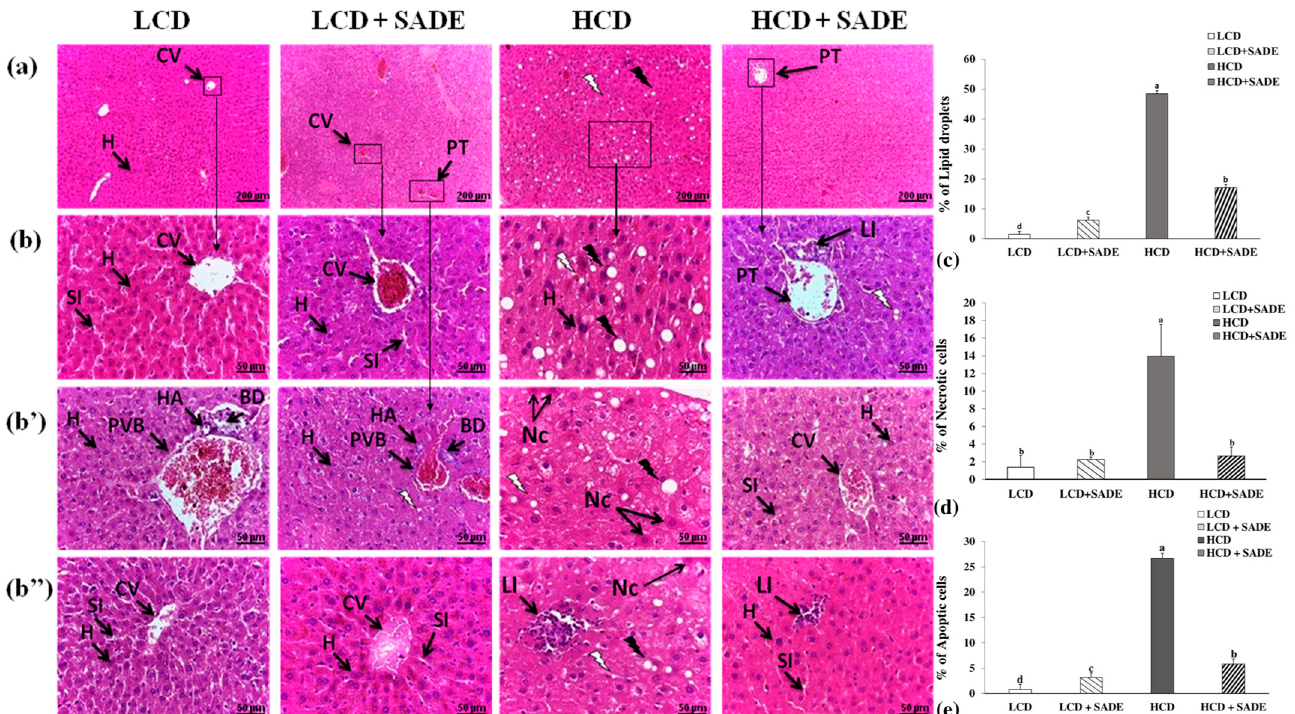
Figure 7. Histological analysis of liver tissues by hematoxylin-eosin (H&E) staining (( a ): magnifica- tion, 10 × , scale bar = 200 µ m), (( b – b” ): magnification, 40 × ; scale bar = 50 µ m). ( b – b” ) represent the different regions of the same slide of each group. Liver sections of LCD: animals group fed with natural low-calorie vegetable diet and LCD + SADE: LCD group treated with S. arabica decocted showed the normal structure of hepatocytes with normal sinusoids and central vein and a normal portal with normal bile ducts ( a – b’’ ). Liver sections of HCD: rats fed with a high-calorie diet demon- strated moderate alterations such as microvesicular and macrovesicular fatty degeneration of hepatocytes ( a – b’’ ), inflammatory ( b’’ ) and necrosis cells ( b’ , b’’ ) and liver sections of HCD + SADE: rats fed with high-calorie diet treated with S. arabica decocted extract reveal a regular aspect of hepatocytes near the normal liver and exhibiting attenuation of inflammation and steatosis ( a – b’’ ). CV: centrilobular Vein, SI: sinusoids, H: hepatocyte, Nc: necrotic cell, PVB: portal vein branch, PT: Portal triad, HA: hepatic artery, BD: bile duct, LI: inflammatory leukocyte infiltrations. Black arrows indicate macrovesicular droplets and white arrows indicate microvesicular droplets. ( c ) Lipid drop- let quantification expressed in percentage of the number of hepatic cells and are means ± SD for triplicate analyses. ( d ) Necrotic cells quantification expressed in percentage of the number of hepatic cells and are means ± SD for triplicate analyses. ( e ) Apoptic cells quantification expressed in the percentage of the number of hepatic cells and are means ± SD for triplicate analyses.